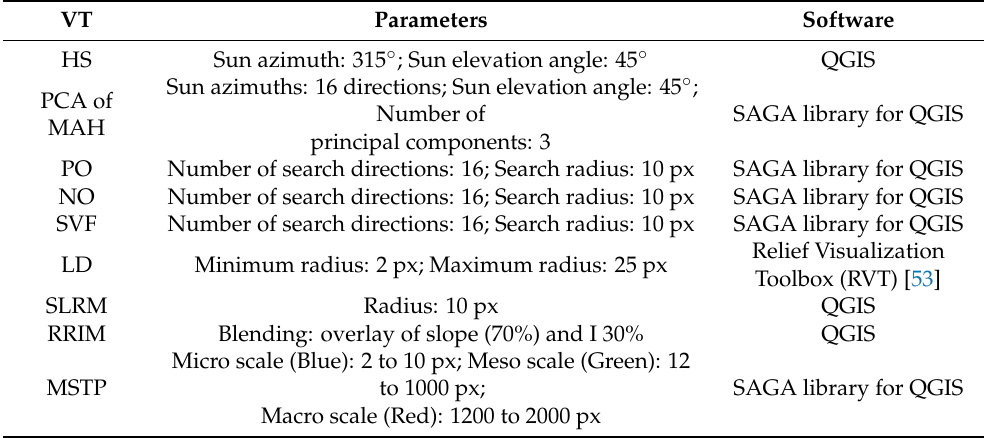
Table 1. Parameters used for each VT and indication of the software used for the